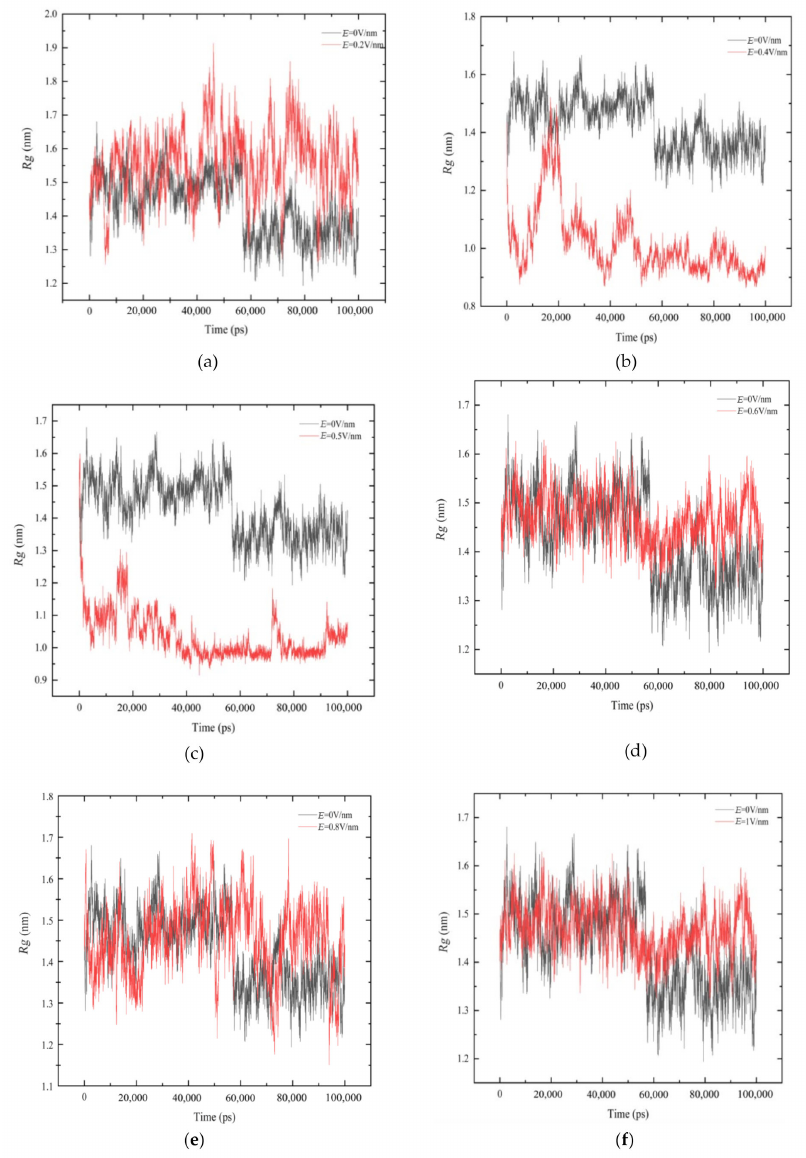
Figure 6. Time evolution of radius of gyration ( Rg ) of the protein GLP-2 are shown under different electric field strength ( a ) E = 0.2 V/nm, ( b ) E = 0.4 V/nm, ( c ) E = 0.5 V/nm, ( d ) E = 0.6 V/nm, ( e ) E = 0.8 V/nm, ( f ) E = 1